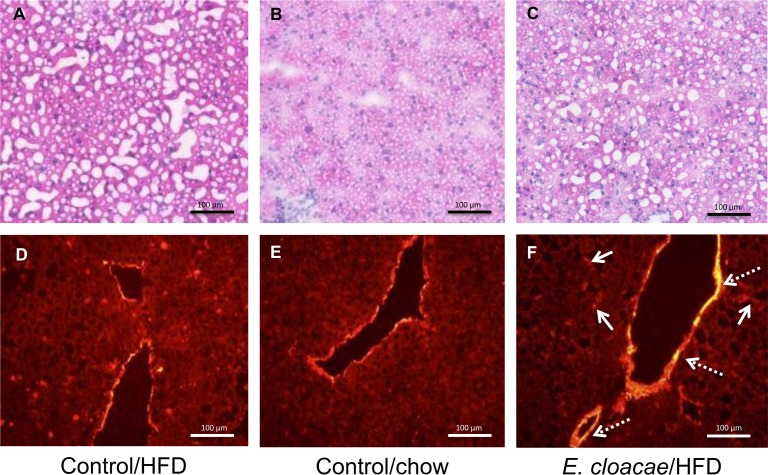
Fibrosis is increased in the liver of E. cloacae -treated mice.(A), (B), and (C) H&E staining; (D), (E) and (F) overexposed anti -smooth muscle actin stainings of the frozen liver tissues. H&E staining shows more ballooning and an increase in lipid droplets in HFD controls and E. cloacae -treated mice compared to chow controls. In SMA staining, an increase in E. cloacae -treated mice compared to chow controls and HFD controls can be seen both in blood vessels (discontinuous arrows) and sites outside the vessels (continuous arrows).